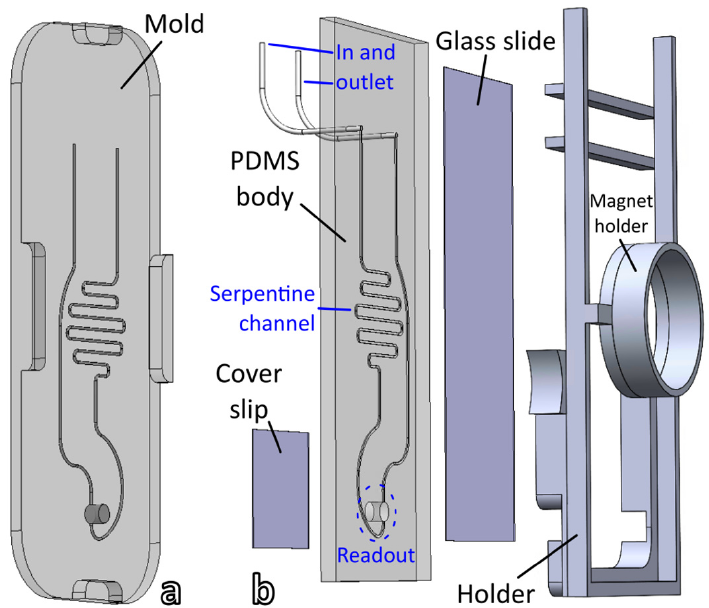
Figure 8. ( a ) Schematic of the 3D-printed mold utilized to shape the PDMS microfluidic cell. The mold is placed face down onto viscous PDMS, the four shoulders determine the thickness of the cell. ( b ) Exploded view of the four components of the microfluidic cell. The glass cover slip and slide are glued to the PDMS using an oxygen plasma. The assembly is then mounted on the cartridge holder to perform UV–vis